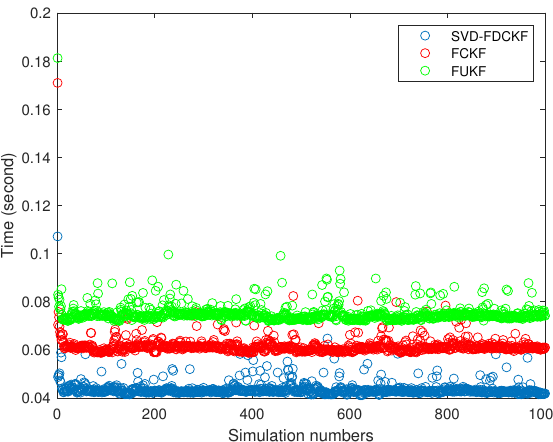
Figure 8. The simulation time in 1000 times Monte Carlo by the SVD-FDCKF, FCKF, and